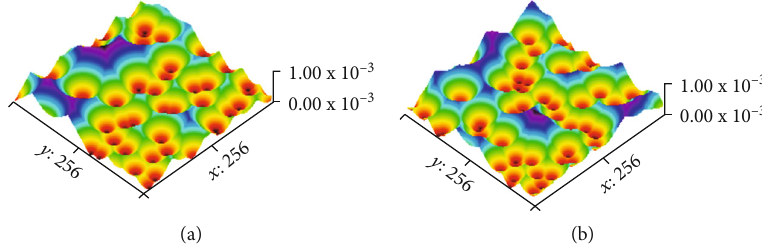
Figure 6: Lattices of the aerosols: (a) bioaerosols and (b) chem-aerosols.